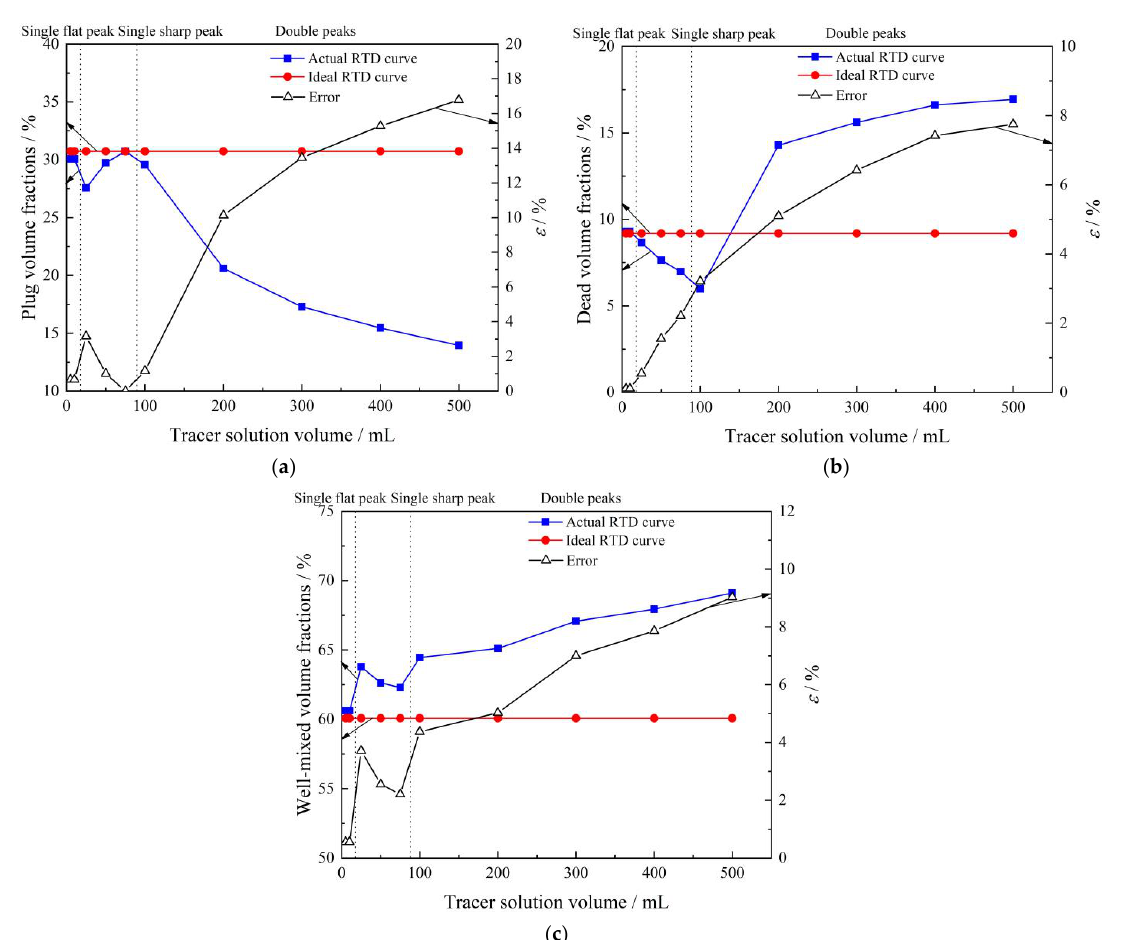
Figure 10. RTD curves analysis result by different tracer solution volumes: (a) plug volume; (b) dead volume; (c) well-mixed volume.